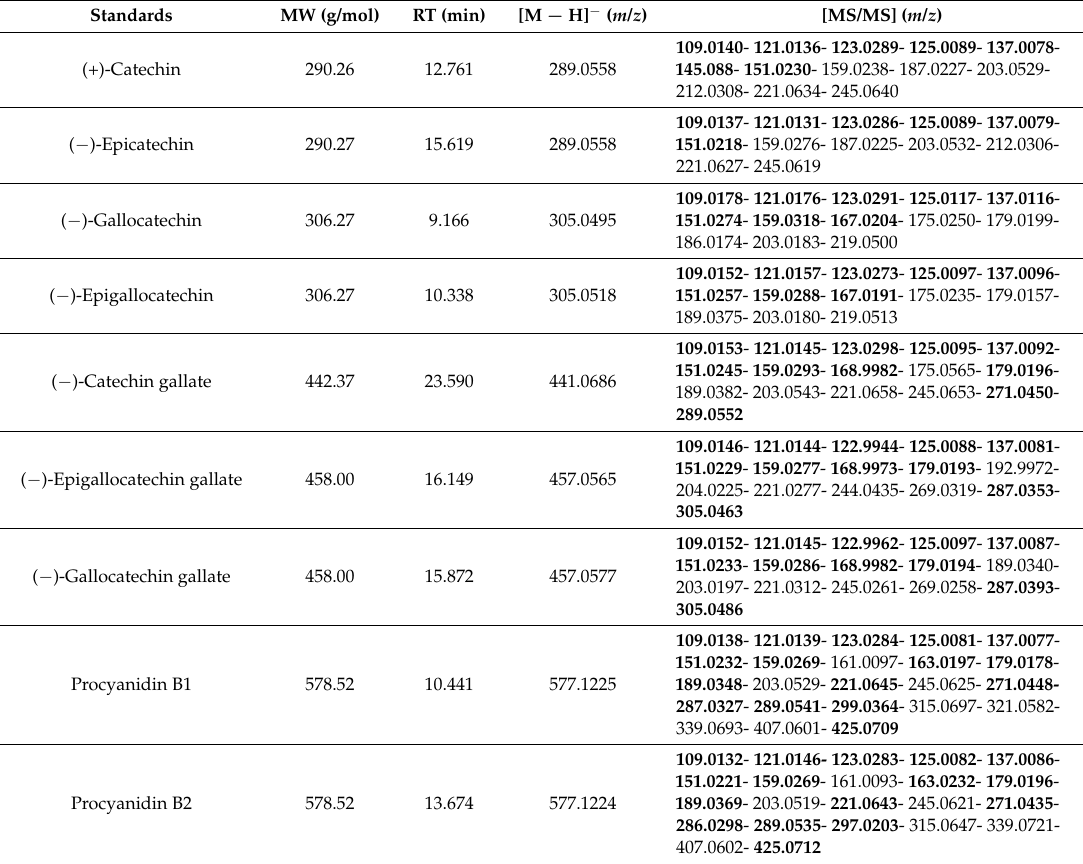
Table 1. Features of mass-to-charge ratios and MS fragmentation profiles generated from HPLC-qTOF -MS/MS of nine standards.